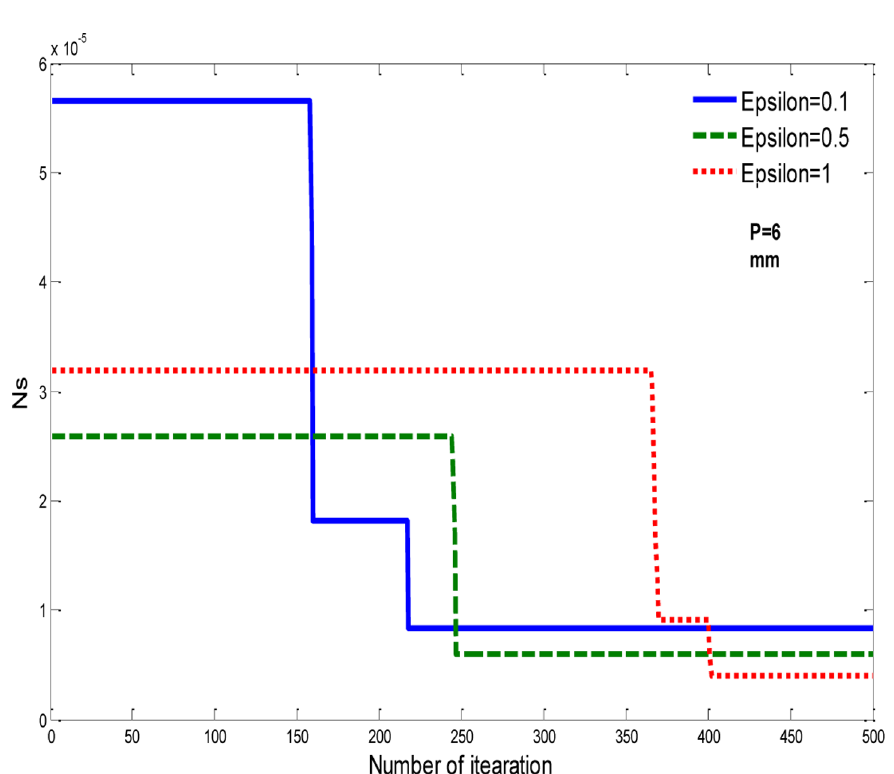
Figure 5. Effect of e on dimensionless total entropy generation rate ( Ns ) of EPF. doi:10.1371/journal.pone.0066080.g005 PLOS ONE |